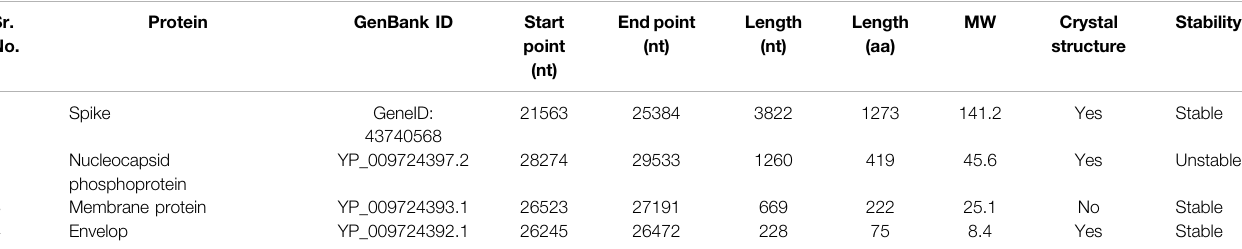
TABLE 2 | Summary of the Structural